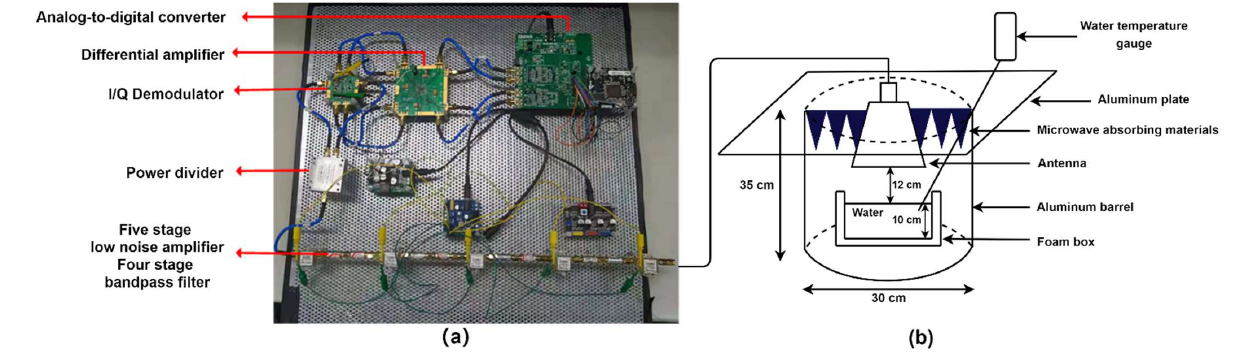
Figure 3. ( a ) Physical picture of broadband correlative microwave receiver; ( b ) Device diagram of non-contact temperature measurement system based on correlative receiver.